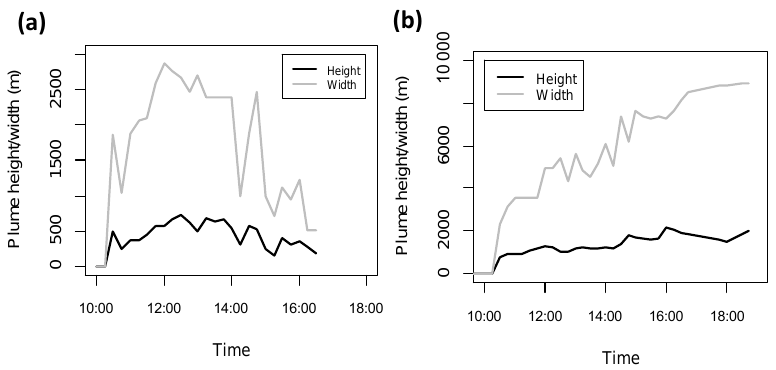
Figure 4. Visual observations of the development of plume height and width for (a) the 52ha fire and (b) the 700ha fire.